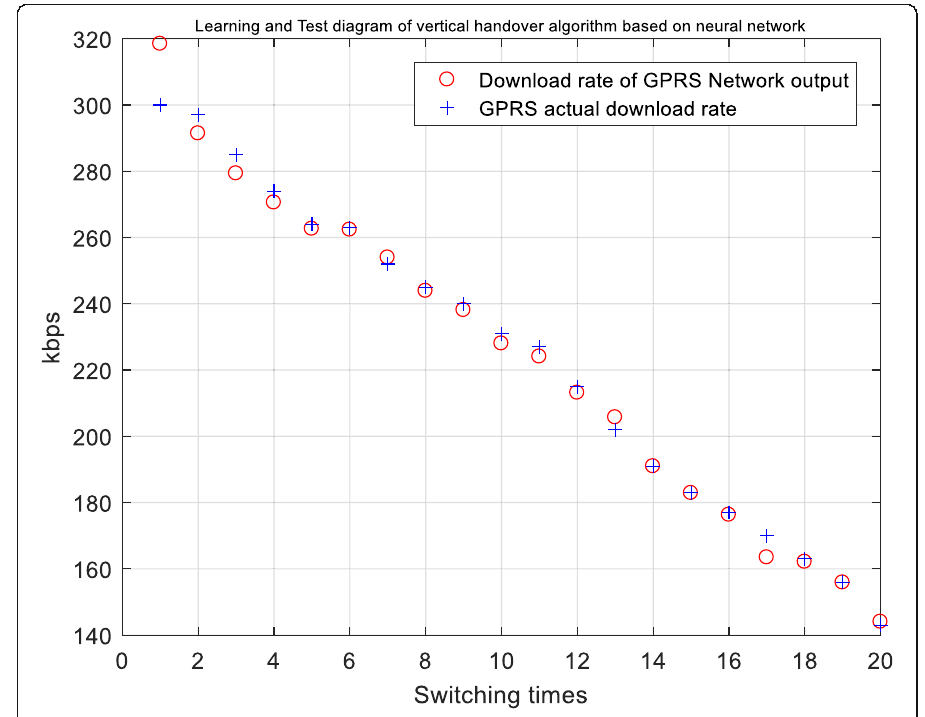
Fig. 8 Contrast curve of data learning and testing in GPRS network